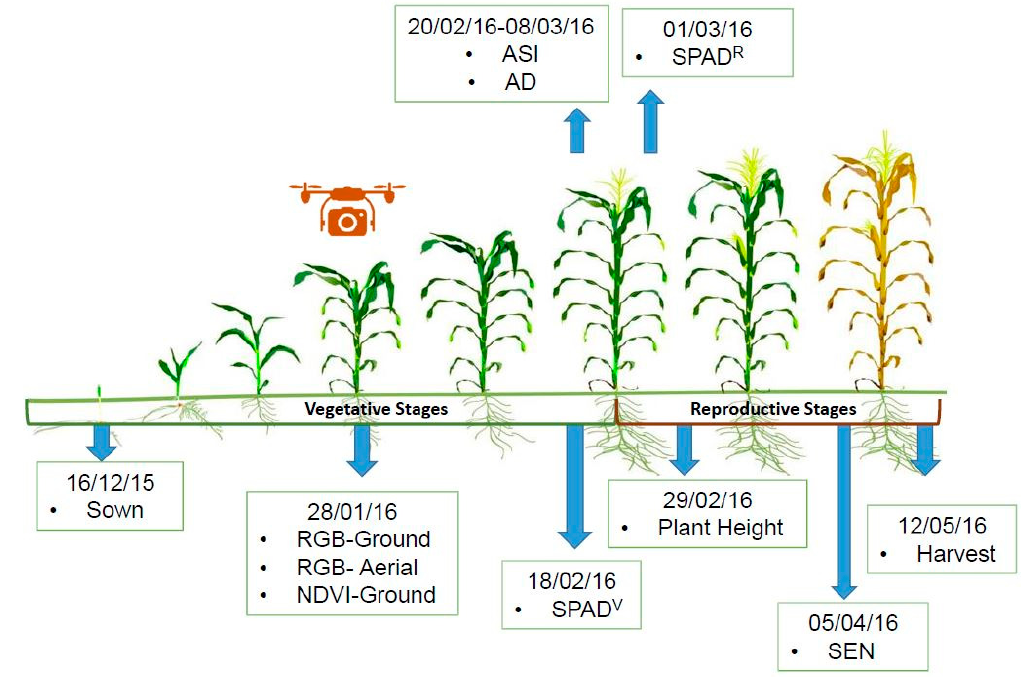
Figure 3. Field phenotyping, field imaging, and unmanned aerial vehicle (UAV) aerial image data capture chronogram for the controlled low-N field trial, showing dates for the measurement of all parameters at vegetative and reproductive stages, including red–green–blue (RGB), (high throughput plant phenotyping (HTPP) imaging, plant height (PH), canopy senescence (SEN), anthesis data (AD), and anthesis silking interval (ASI).